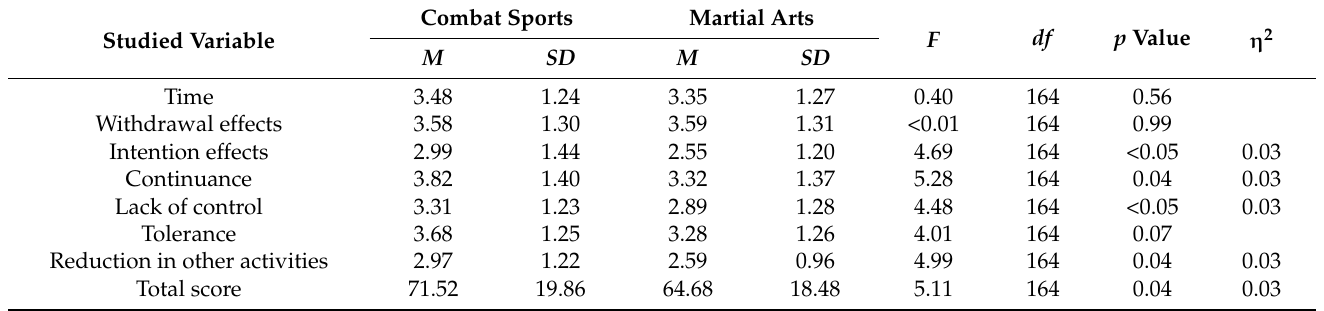
Table 3. Comparison of results by between respondents practicing martial arts and combat